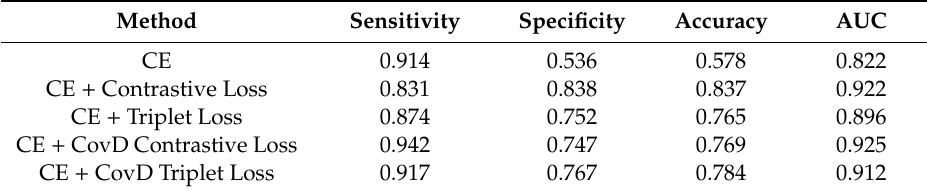
Table 1. The e ff ect of di ff erent embedding losses. Table 1. The effect of different embedding losses.